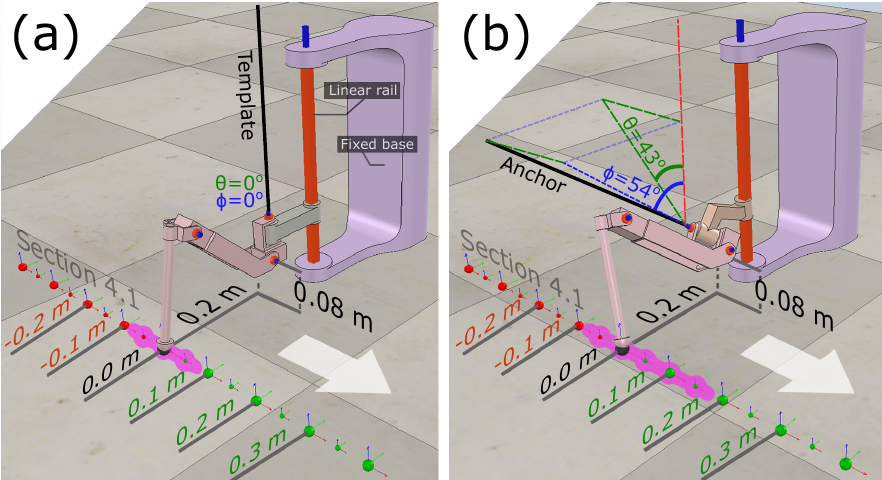
Figure 9. The CoppeliaSim simulation setup used throughout the analysis (Section 6) for measuring and comparing the motor torques of legs with a ( a ) template morphology and ( b ) anchor morphology. Each leg was loaded with 2.0 kg, and their origin point was positioned 0.08 m above ground. The stepping intervals of the first tests (Section 6.1) are also depicted, where the stepping line is 0.20 m lateral to the origin point. The white arrows indicate forward movement